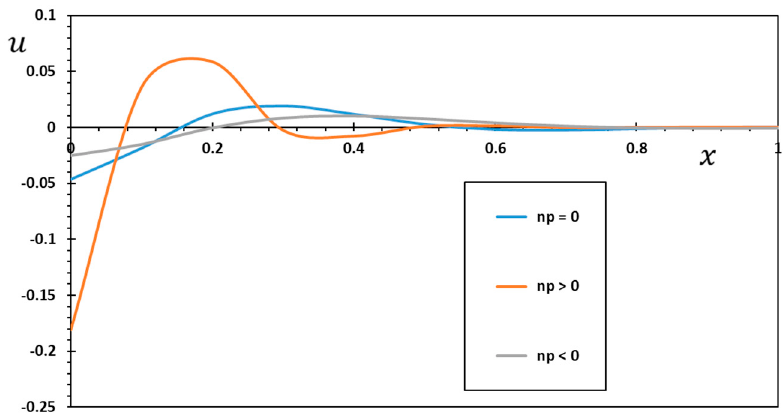
Figure 13. Effect of the gradient indicator on the dimensionless bending moment, 𝑀 . 9. Conclusions This paper thoroughly studies a mathematical fractional thermoelastic framework for a functionally graded Euler–Bernoulli nanobeam subjected to a periodic heat flow. Variations in through-thickness features range from purely ceramic to purely metallic. The model employs both nonlocal elasticity theory and generalized MGT thermoelasticity with fractional derivative operators. The Atangana–Baleanu (AB) fractional derivative op- erator without singular kernels is a novel definition introduced by the revised heat con- duction equation. Both analytical and numerical studies show that the nonhomogeneity parameter (gradient indicator), the nonlocal parameter, and the fractional differential op- erators significantly impact field variables. According to the results of the previous re- search: •